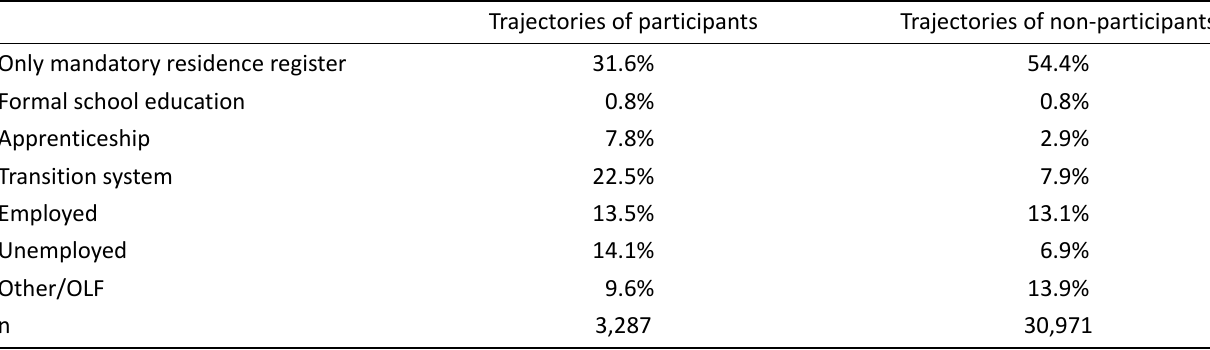
Table 4. Trajectories of students who participated in the transition system compared to non‐participants, 24 months after the reference date (n =